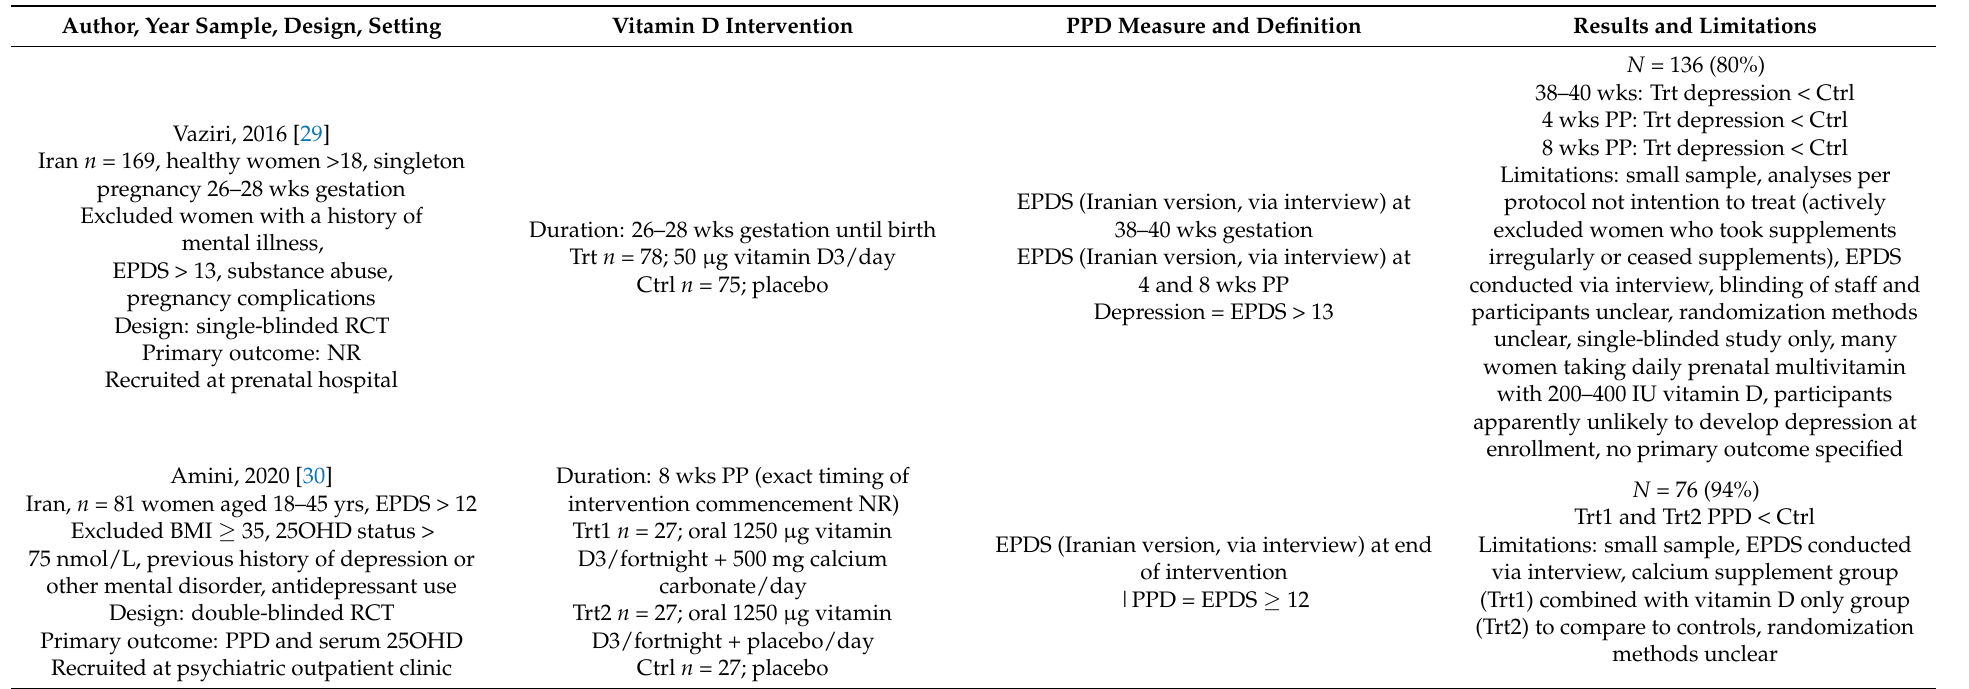
Table 1. Randomized controlled trials of vitamin D supplementation in the antenatal and postpartum period and